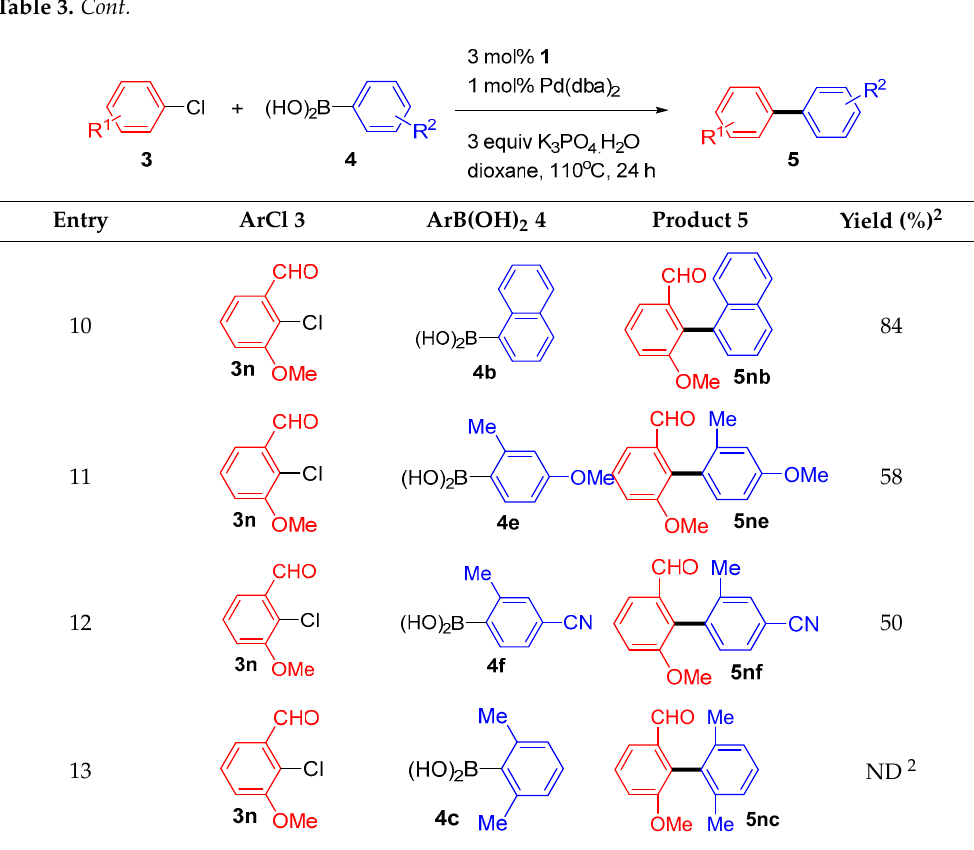
Table 3. Poly- ortho -substituted biaryl synthesis using in situ-generated catalyst. Table 3. Cont.